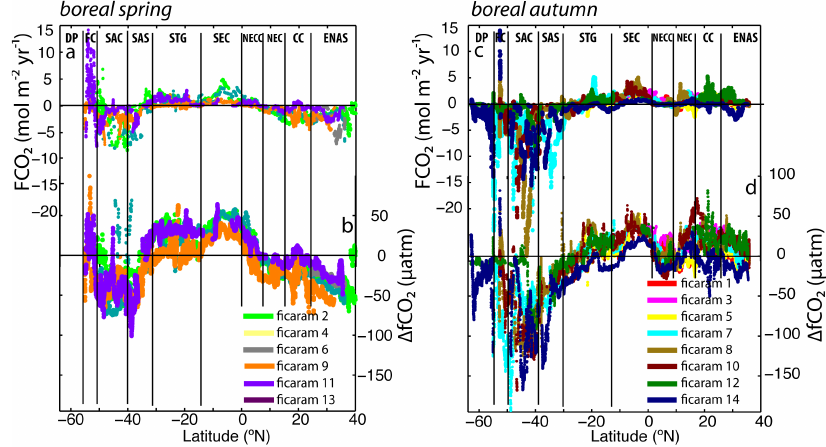
Fig. 3. Latitudinal distributions during boreal springs (a, b) and boreal autumns (c, d) of F CO 2 and 1f CO 2 as measured in the FICARAM